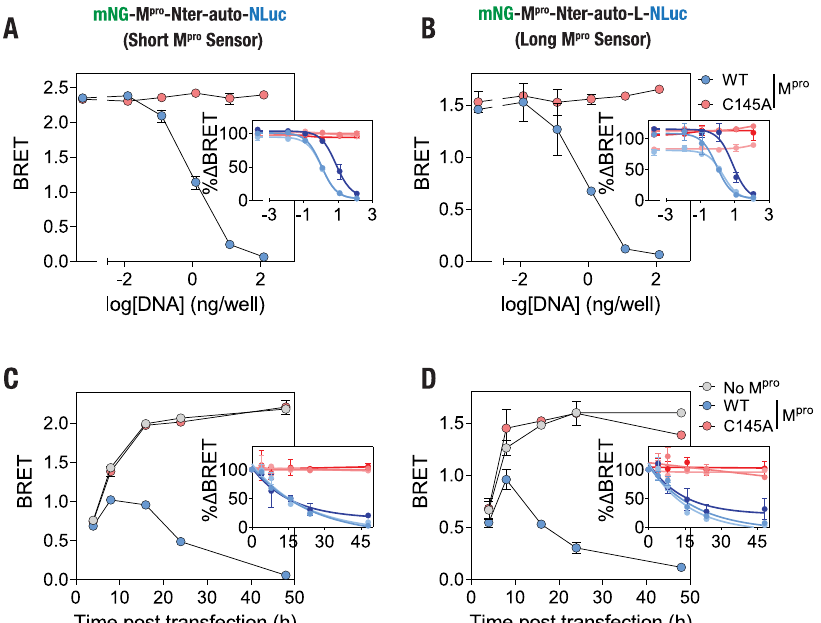
Fig. 4 M pro DNA concentration- and time-dependent cleavage of the M pro sensors in live cells. A , B Graph showing BRET ratio of the short ( A ) and the long ( B ) M pro sensors in cells transfected with the indicated amounts of either the wild type or the C145A mutant M pro plasmid DNA. Insets: graph showing percentage decrease in BRET ratio compared to the control cells when transfected with the indicated amounts of the wild type M pro plasmid DNA. Data shown are mean ± S.D. from a representative of three independent experiments, with each experiment performed in triplicates. Data shown in insets are % change in BRET (mean ± S.D) obtained from all three independent experiments and fi tted to a sigmoidal dose-response curve. C , D Graphs showing the BRET ratio of the short ( C ) and the long ( D ) M pro sensors at the indicated time post transfection in either control cells or cells transfected with the wild type or the C145A mutant M pro . Insets: graph showing percentage change in BRET ratio compared to the control cells with time when transfected with the wild-type or mutant M pro . Data shown are mean ± S.D. from a representative of three independent experiments, with each experiment performed in triplicates. Data shown in insets are % change in BRET (mean ± S.D) obtained from all three independent experiments and fi tted to a one-phase decay